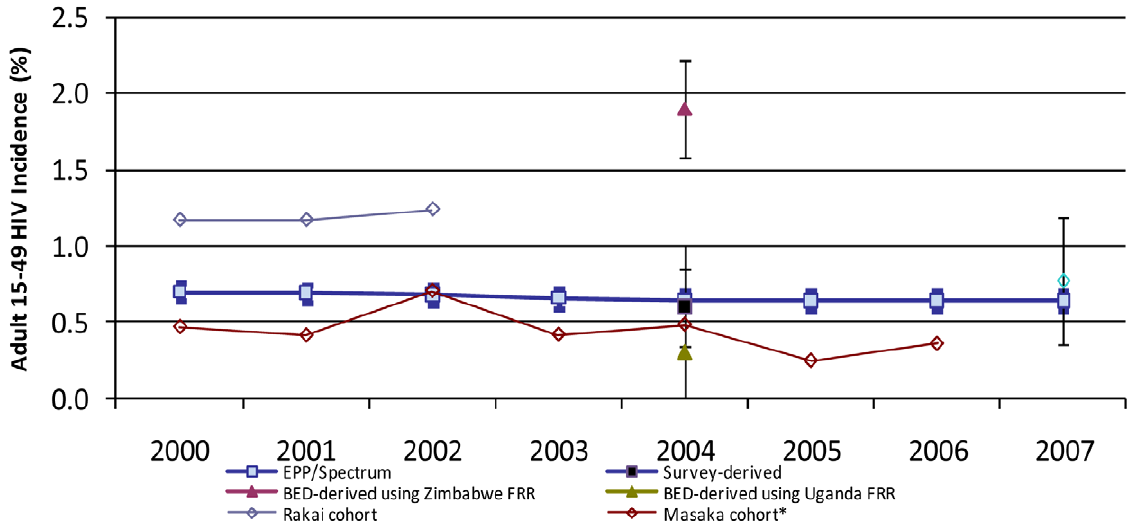
Figure 4. Trends in HIV prevalence among young women aged 15–24 years attending antenatal clinics in Uganda, 2000–2007.